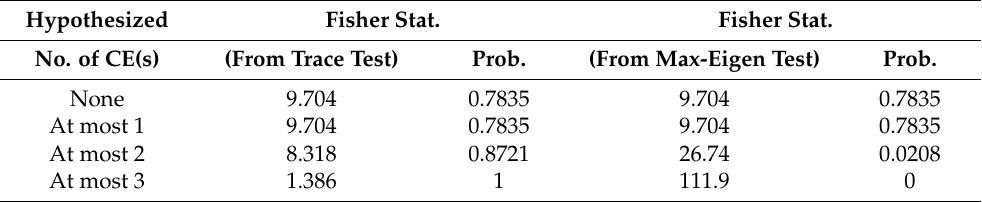
Table 5. Panel cointegration test results.